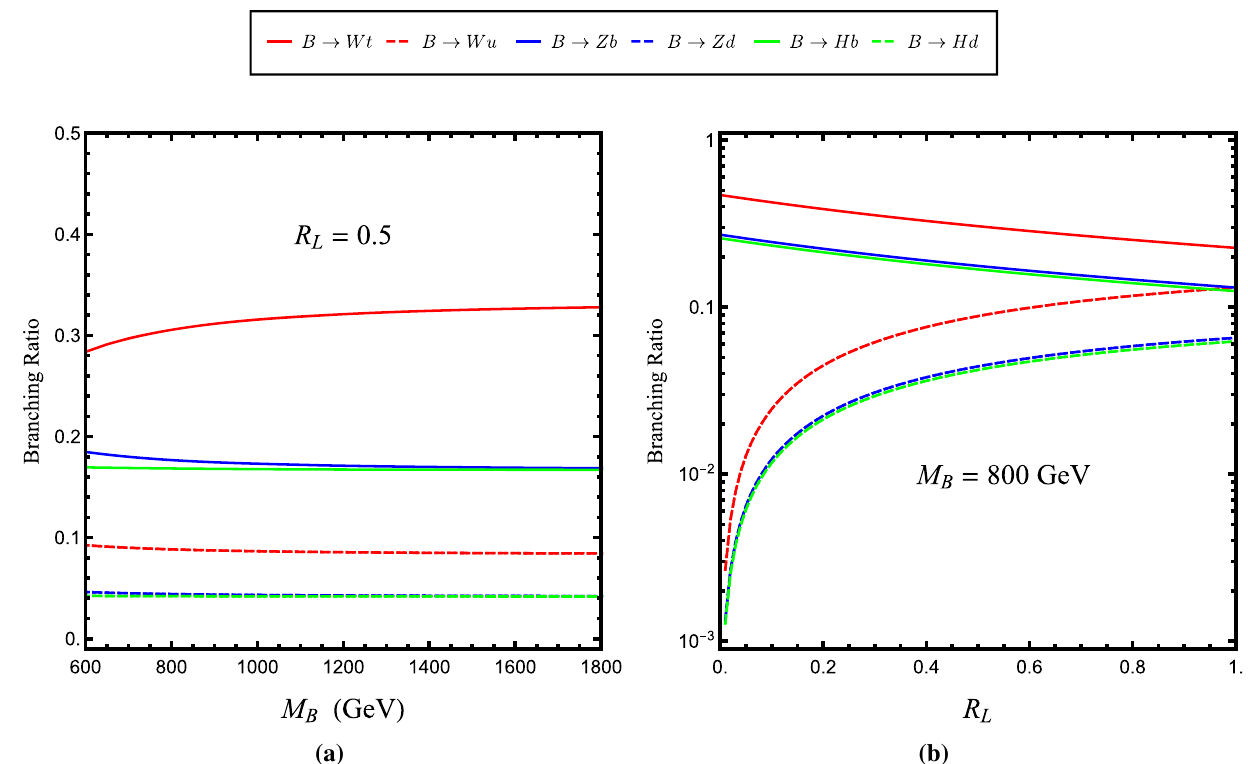
(left) and the generation mixing coupling B